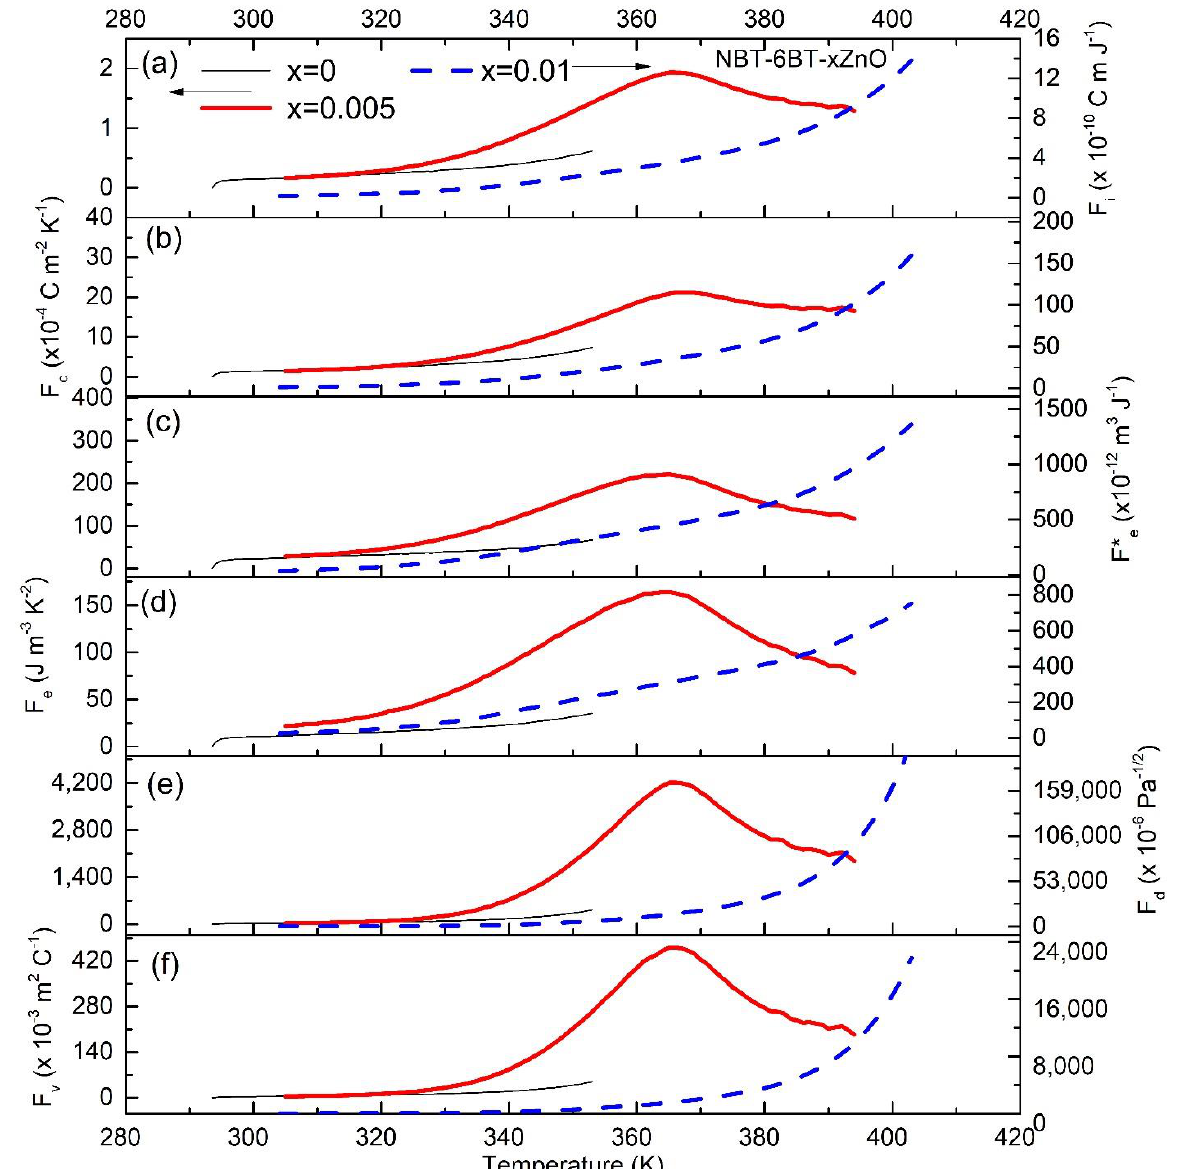
Figure 6. Pyroelectric figures of merit versus temperature plots of NBT-6BT-xZn (x = 0.005 and 0.01) for ( a ) current responsivity 𝐹 𝑖 , ( b ) the pyroelectric figure of merit 𝐹 𝑐 , energy harvesting ( c ) 𝐹 𝑒∗ and ( d ) 𝐹 𝑒 . ( e ) detectivity 𝐹 𝑑 and ( f ) voltage responsivity 𝐹 𝑣 . Similarly, at room temperature, 𝐹 𝑣 increases with increasing ZnO content, which is found as 17.9, 28.20 and 34.5 × 10 −3 m 2 C −1 and 10, 13.6 and 23 × 10 −3 m 2 C −1 for NBT-6BT- xZn and NBT-9BT-xZn (x = 0, 0.005 and 0.01), respectively, as seen in Figures 6b and 7b. A similar trend is observed for pyroelectric energy harvesting FOMs ( 𝐹 𝑒∗ ) and ( 𝐹 𝑒 ) as seen in Figures 6c,d and 7c,d.